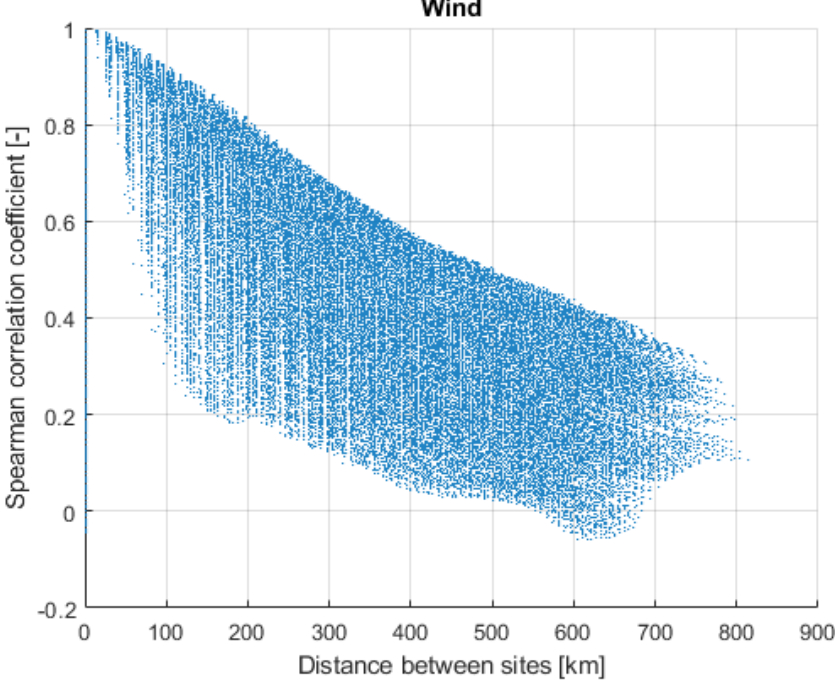
Figure 14. Spatial smoothing (decorrelation) for wind resources across Poland based on hourly time series, 1980 – 2019.